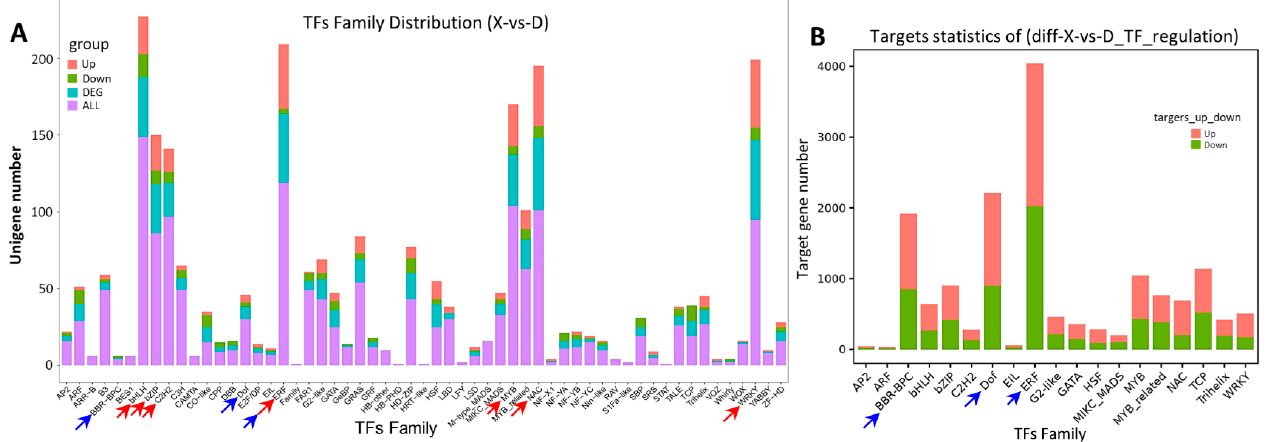
Figure 4. The TF families and their targets. ( A ) Distribution of DEGs in TF families. X-axis and Y-axis represent TF families and gene number, respectively. The red and green bars indicate the number of upregulated and downregulated TFs, respectively. The cyan bars indicate total DEGs, and the purple bars indicate total genes identified in TF families. ( B ) The target gene families of TFs. The red and green bars represent the number of upregulated and downregulated target genes, respectively.